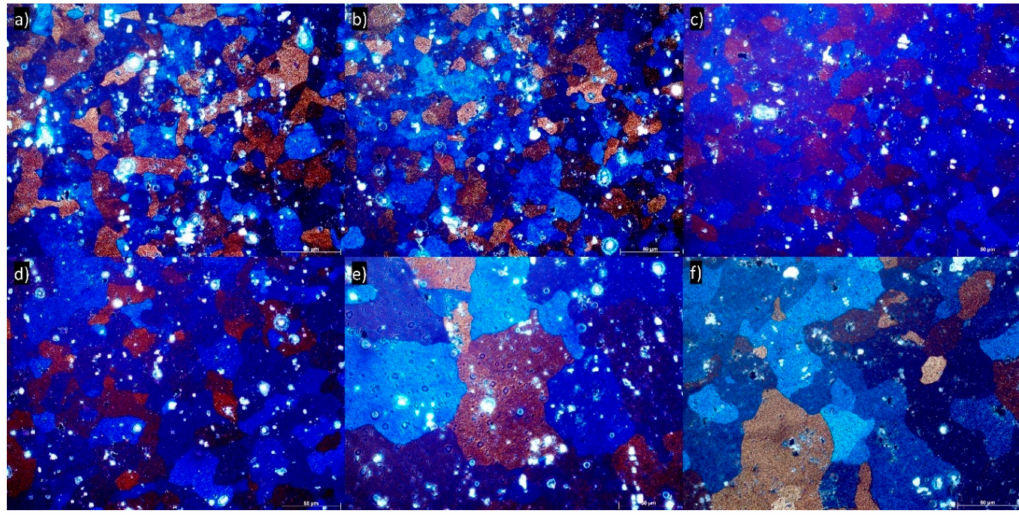
Figure 8. Examples of grain structures of 5754 aluminum alloy subjected to annealing for 30 min ( a ) 150 ◦ C, ( b ) 180 ◦ C, ( c ) 200 ◦ C, ( d ) 250 ◦ C, ( e ) 300 ◦ C, and ( f ) 350 ◦